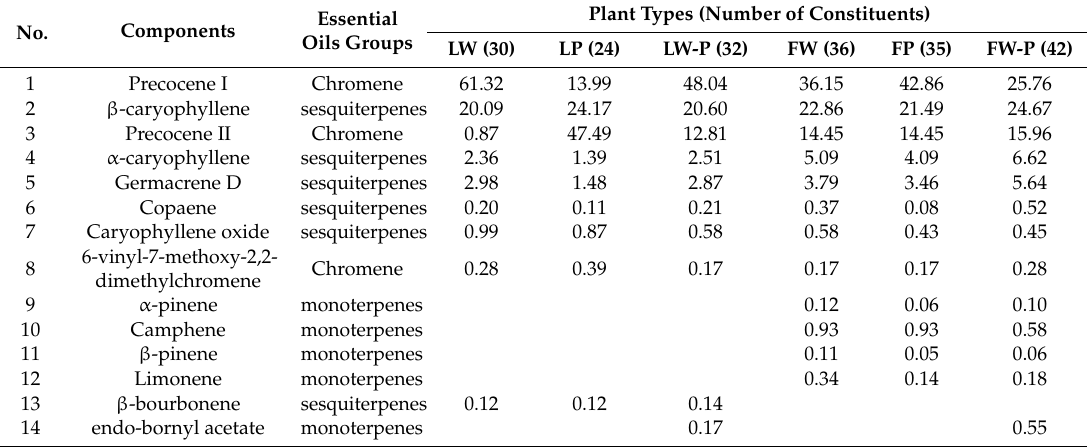
Table 5. The chemical constituents and components of six types of essential oils of A. conyzoides , expressed as percent of total